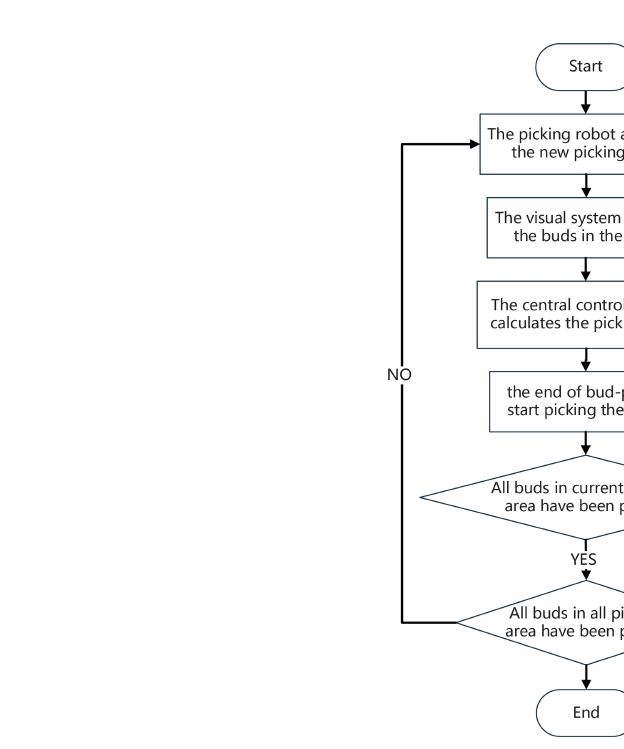
FIGURE 2 The working fl owchart of the picking robot.